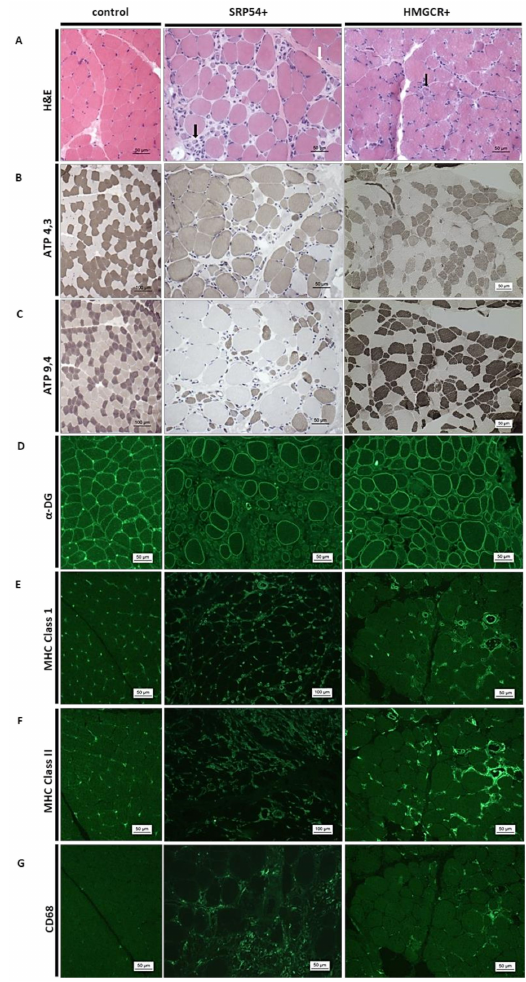
Figure 4. Muscle biopsy findings in pediatric IMNM patients; the middle column seropositive patient for SRP54, and the right column is seropositive patient for HMGCR. Patient 1